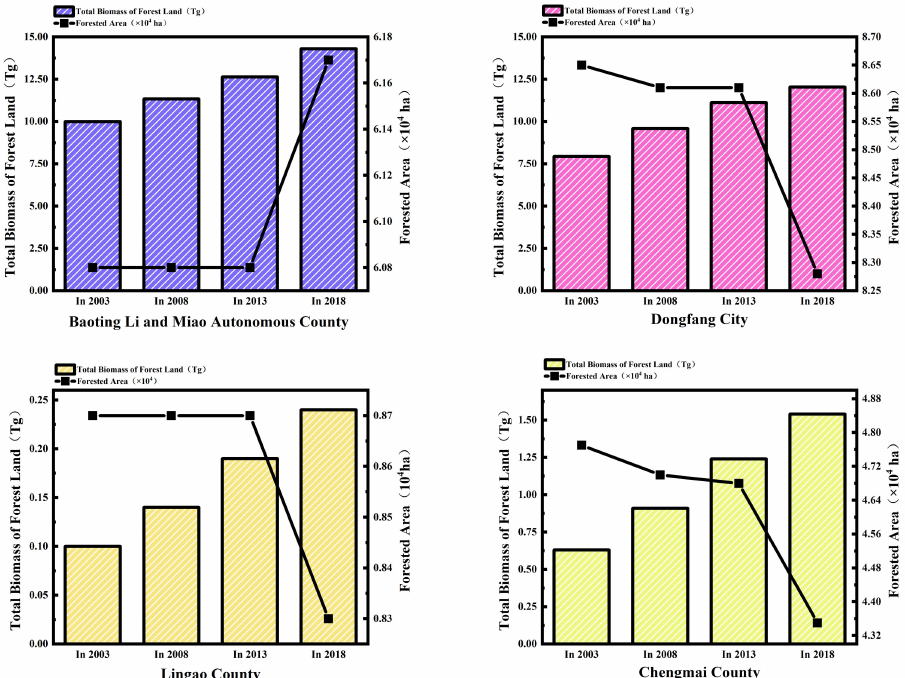
Figure A1. Trends of biomass and forestland area of tropical rainforest in different cities and counties in Hainan Island from 2003 to